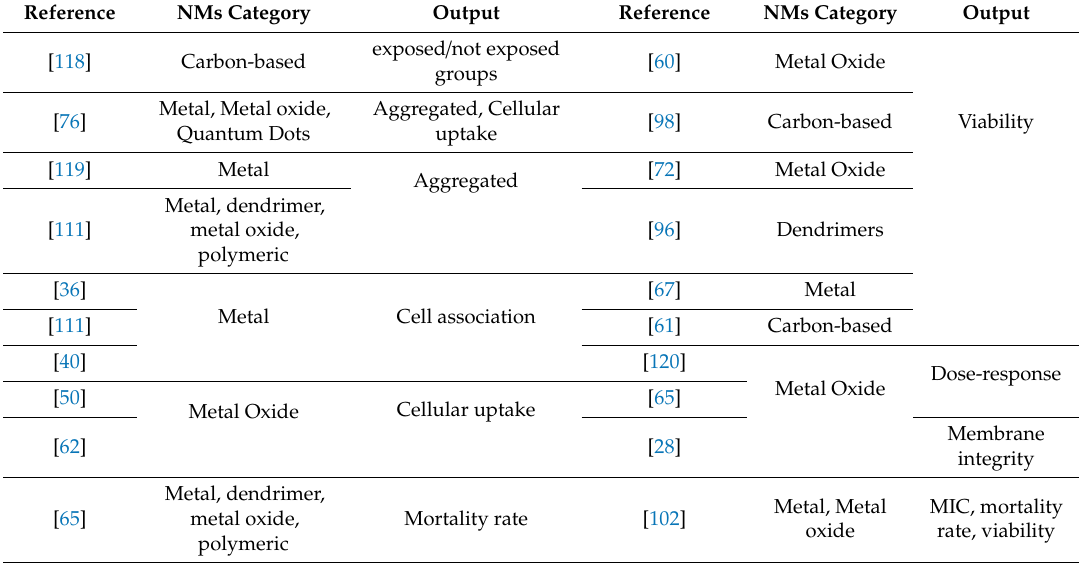
Table 5. Endpoints predicted by instance-based tools extracted from the studies